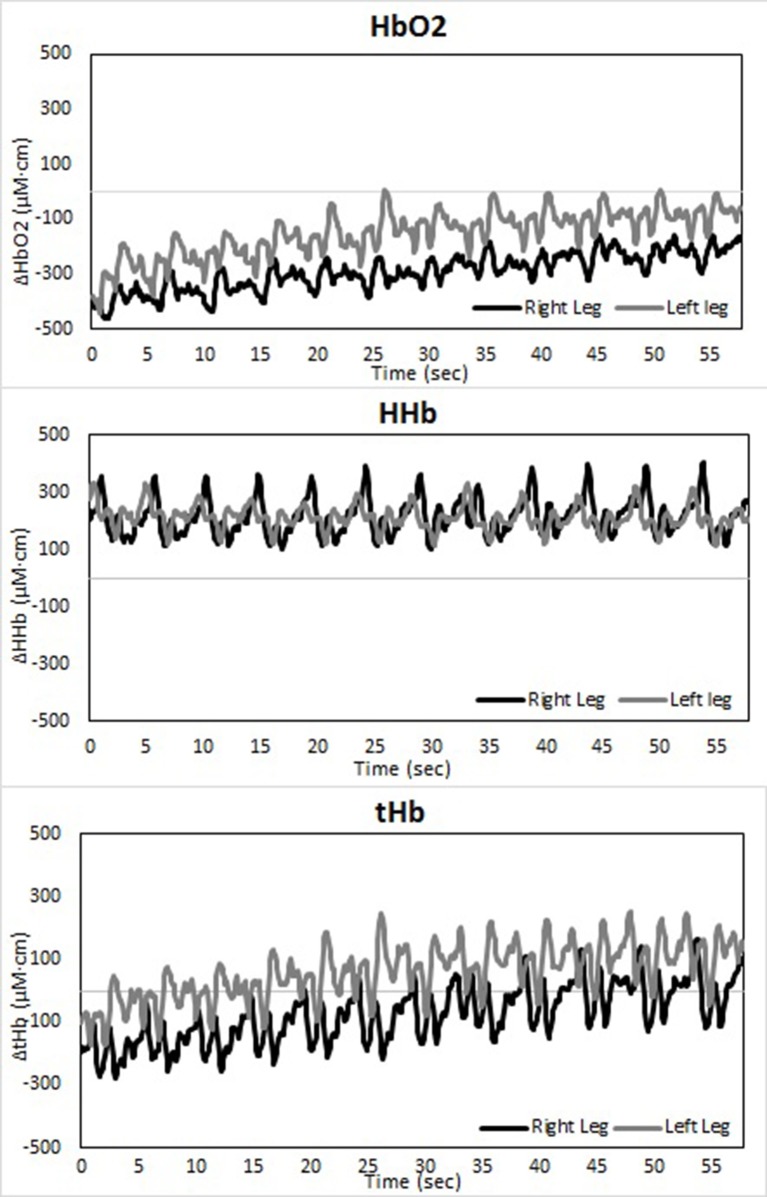
Temporal changes in right and left vastus lateralis during the short-track time trial: HbO2 (upper panel), HHb (middle panel), and tHb (lower panel).